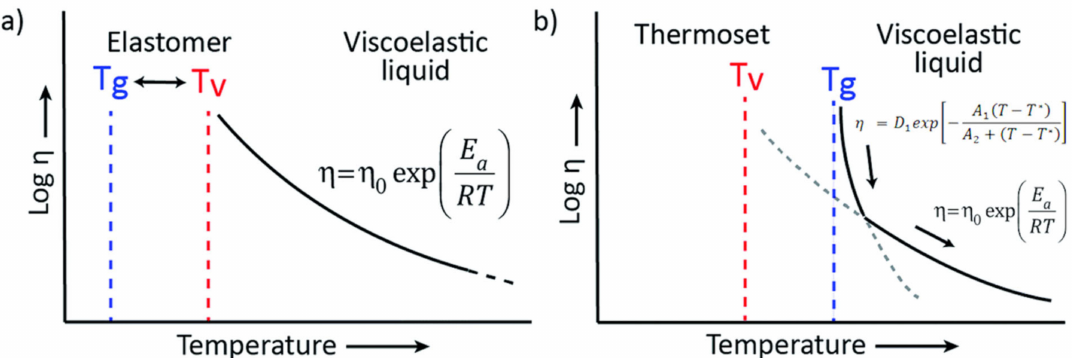
Figure 1. Representation of the viscoelastic behavior of vitrimers with ( a ) a glass transition, T g , lower than the topology freezing transition temperature, T v . Upon heating, the vitrimer evolves from a glassy solid (T < T g ) to an elastomer (T g < T < T v ) to a viscoelastic liquid (T > T v ) that follows the Arrhenius law. ( b ) A hypothetical Tv is situated well below T g . Upon heating, the vitrimer evolves from a glassy solid to a viscoelastic liquid with a viscosity that is first controlled through diffusion (WLF) and then by the exchange kinetics (Arrhenius). Adapted from Reference [72] under a Creative Commons Attribution 3.0 Unported